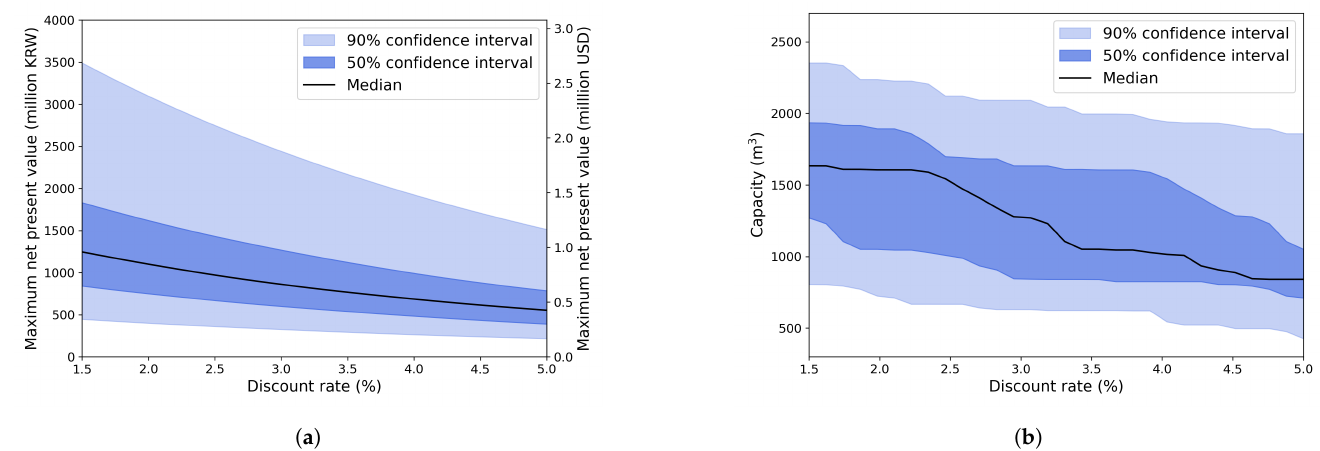
Figure 11. The results of the uncertainty analysis for the inflation rate: ( a ) the maximum net present value; ( b ) the corresponding capacity.